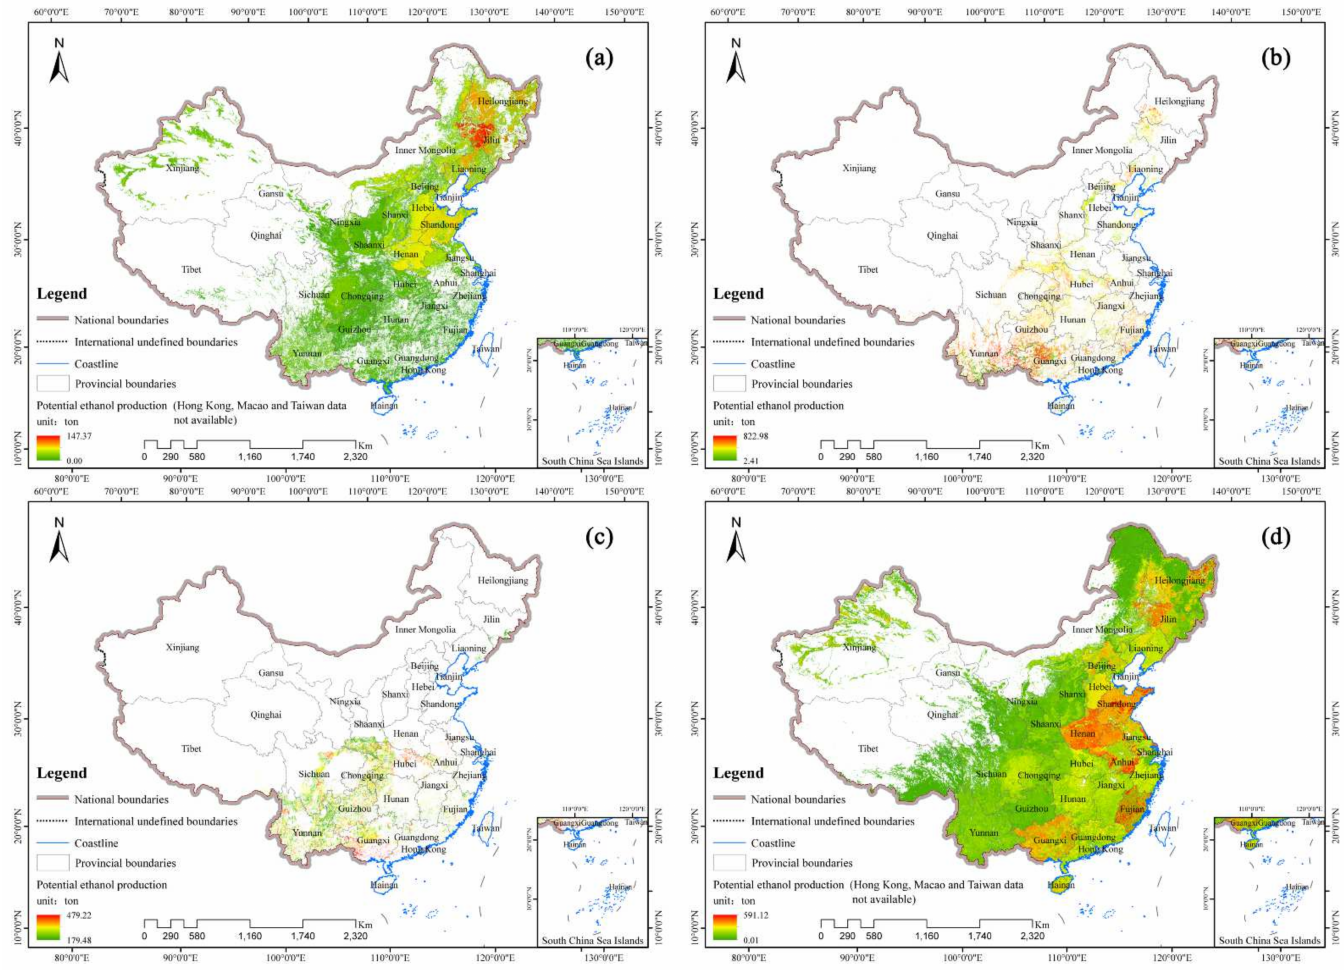
Figure 3. The distribution of bioethanol yield potential in three stages in China: ( a ) first stage; ( b ) second stage; yield potential based on ( c ) switchgrass in the third stage; and ( d ) crop straws and forest residues in the third